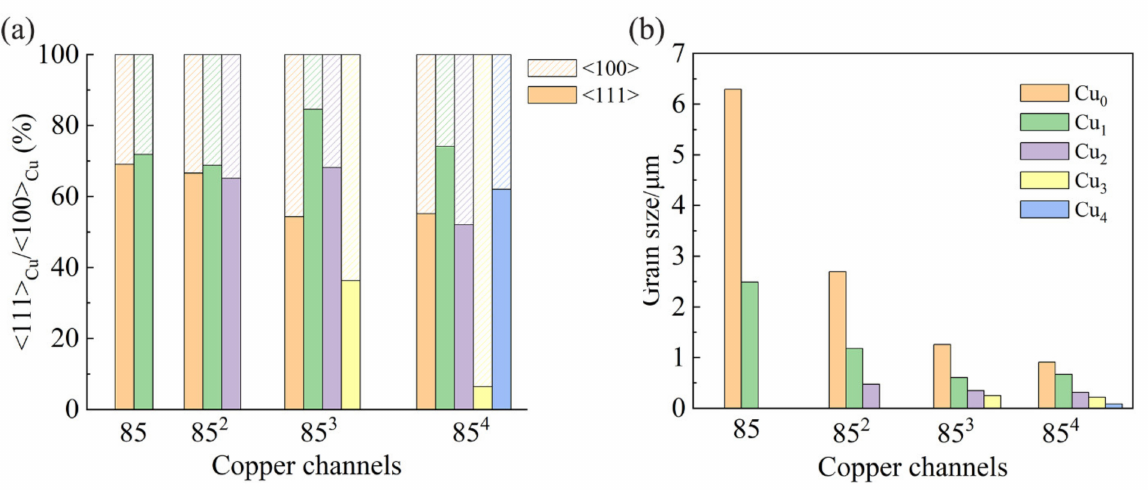
Figure 3. ( a ) Normalized area fraction of <111> and <100> texture in copper matrix, ( b ) grain size of copper matrix in different samples.